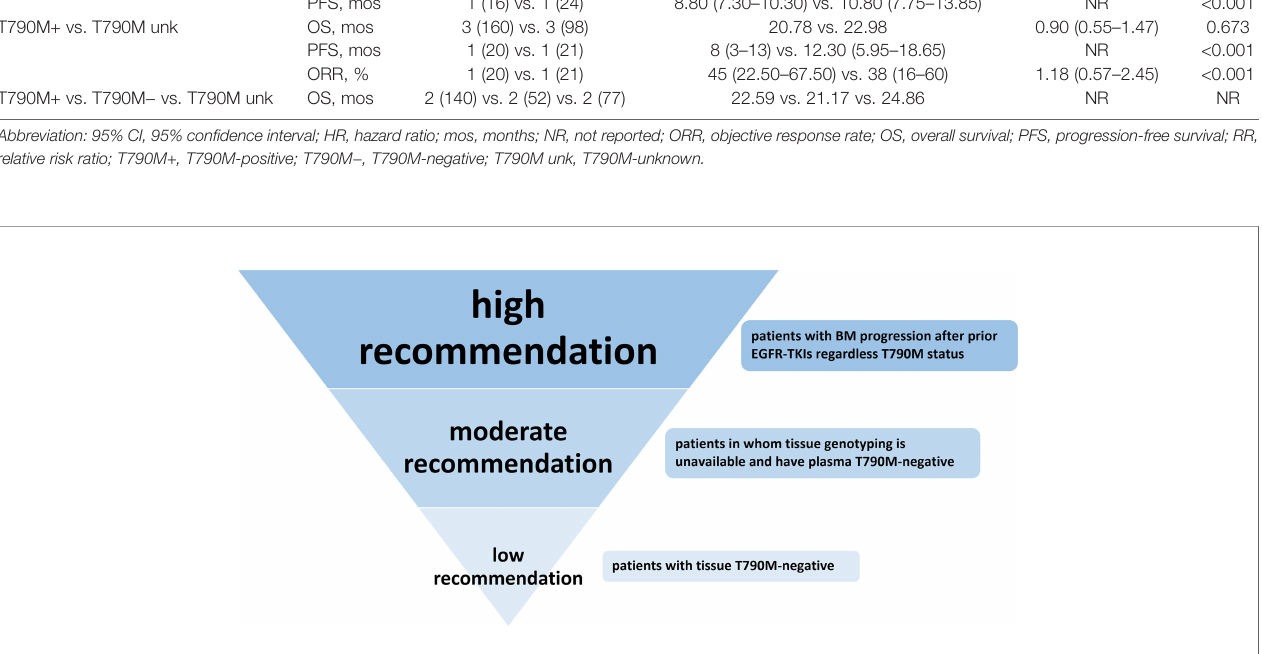
FIGURE 5 | Recommendation level of osimertinib treatment for NSCLC patients with T790M-negative or T790M-unknown status after resistance to fi rst- or second- generation EGFR-TKIs.